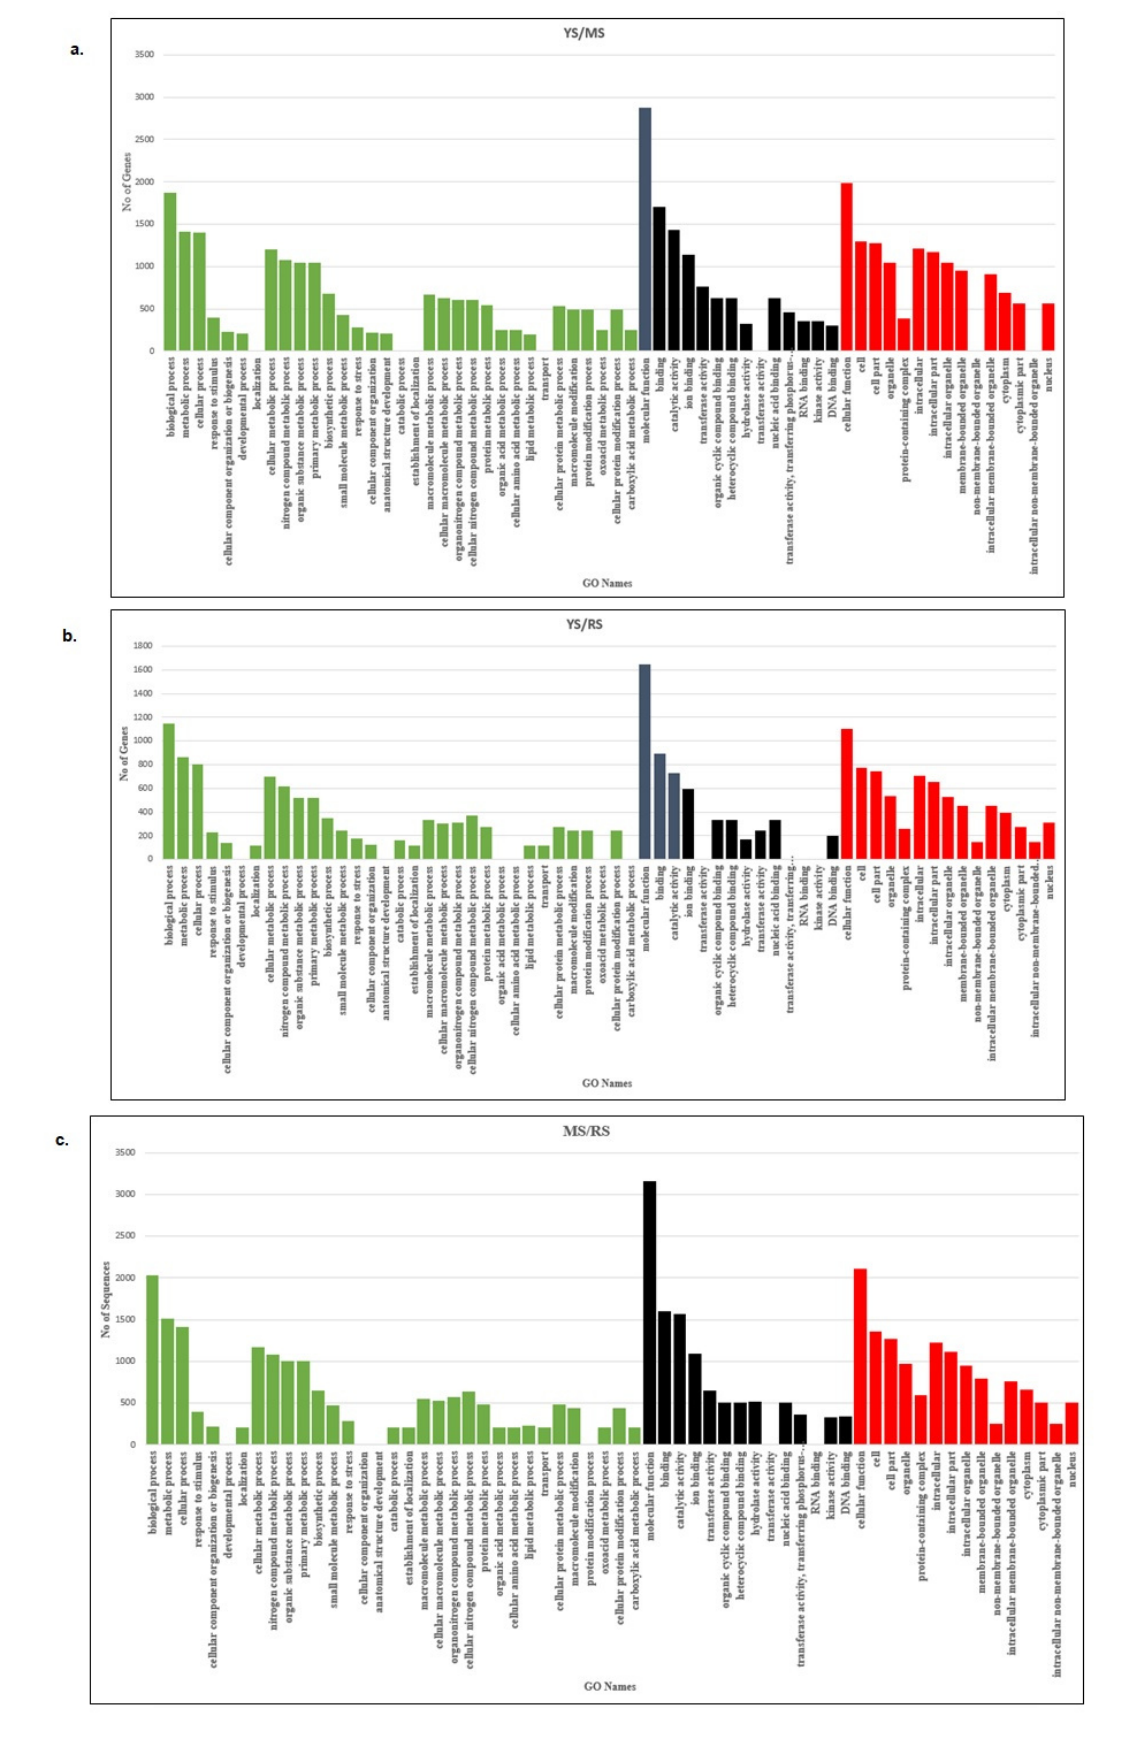
Figure 4 − GO terms classification in a) YS/MS, b) YS/RS, and v)